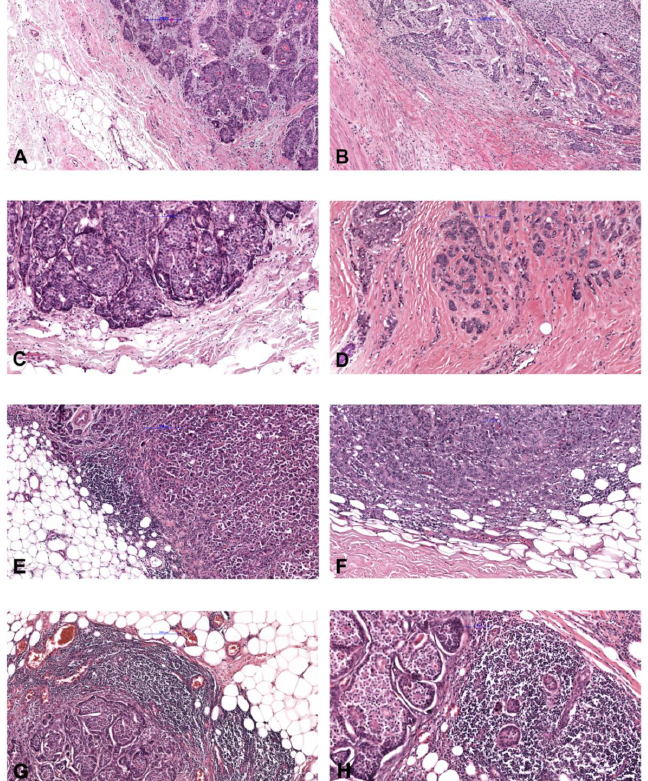
Figure 1. sTILs evaluation within the borders of the invasive tumor. 0 – 10% ( A – D ; magnification A , B ×50, C ×300, D – F ×400), >10 – 50% ( E , F ) and >50% ( G , H ) of the stromal area shows a mononuclear infiltrate.